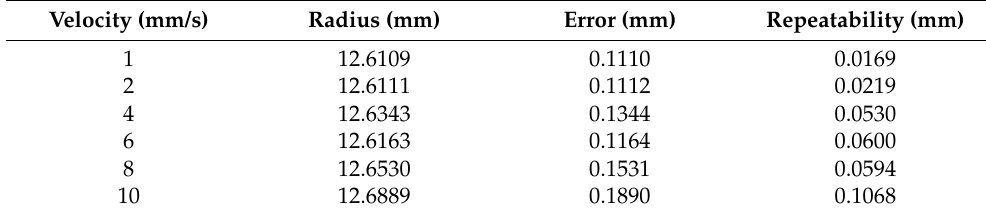
Table 3. Measurement results of the approach velocity experiment.